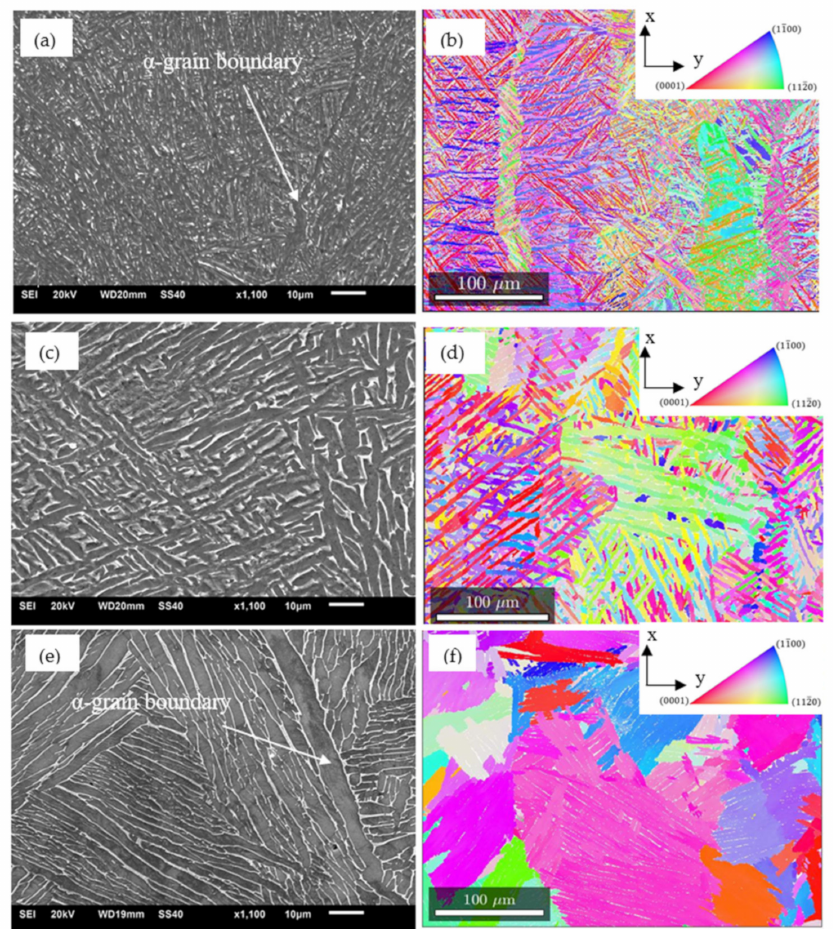
Figure 4. ( a , c , e ) Secondary electron images and ( b , d , f ) EBSD orientation maps of ( a , b ) samples C, ( c , d ) samples D, and ( e , f ) samples E, respectively. The inserts in ( b , d , f ) are keys for the inverse pole figures